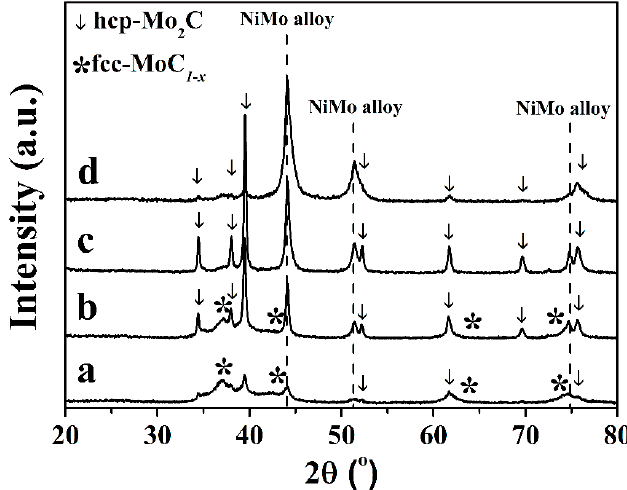
Figure 5. XRD patterns of the calcined catalysts: ( a ) Ni 0.5 MoC–SiO 2 (700); ( b ) Ni 1 MoC–SiO 2 (700); ( c )